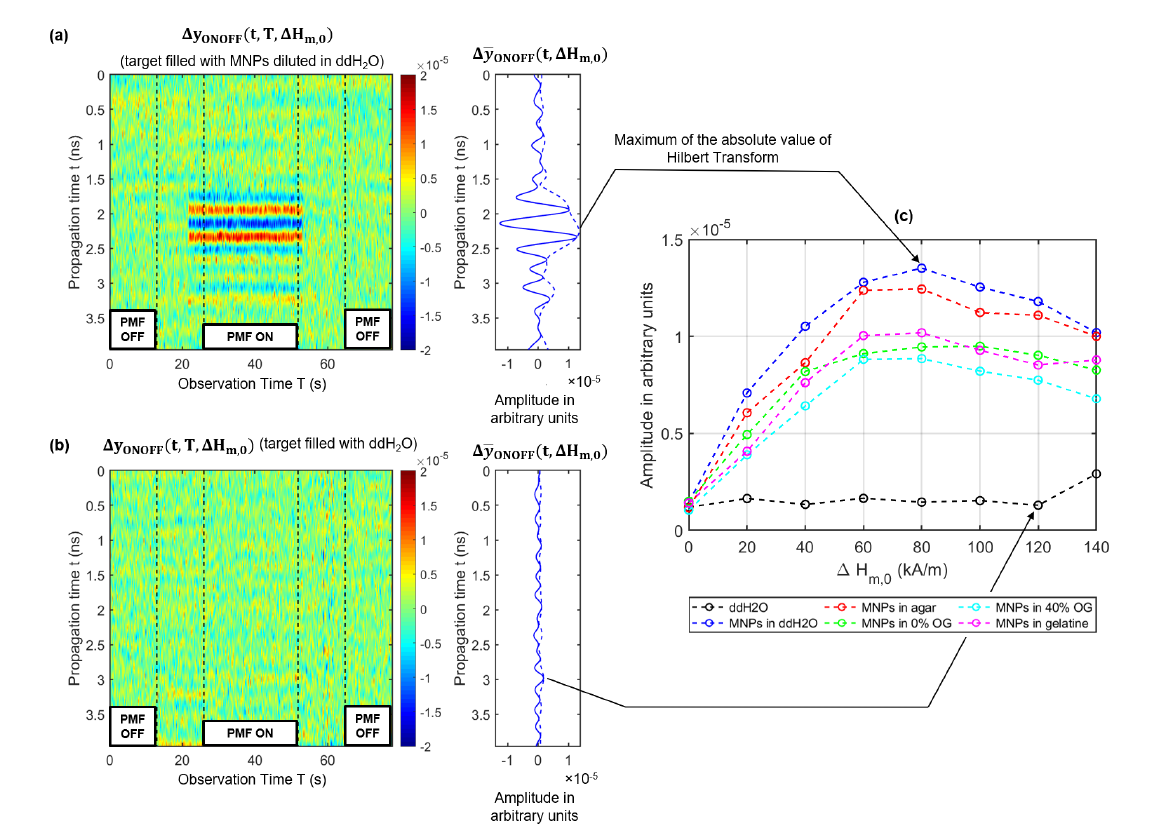
Figure 6. ( a ) Clutter removed radargram and the mean response for the target filled with MNPs diluted in distilled water. ( b ) Clutter removed radargram and the mean response for the reference target filled with distilled water. ( c ) Maximum of the envelope of the MNP responses as a function of the magnetic field intensity for different targets, whereby 0% OG and 40% OG indicate the mixture ratio of oil in gelatin corresponding to Lazebnik et al. [32]. The black curve corresponds to the reference measurement where the target is filled with distilled water without